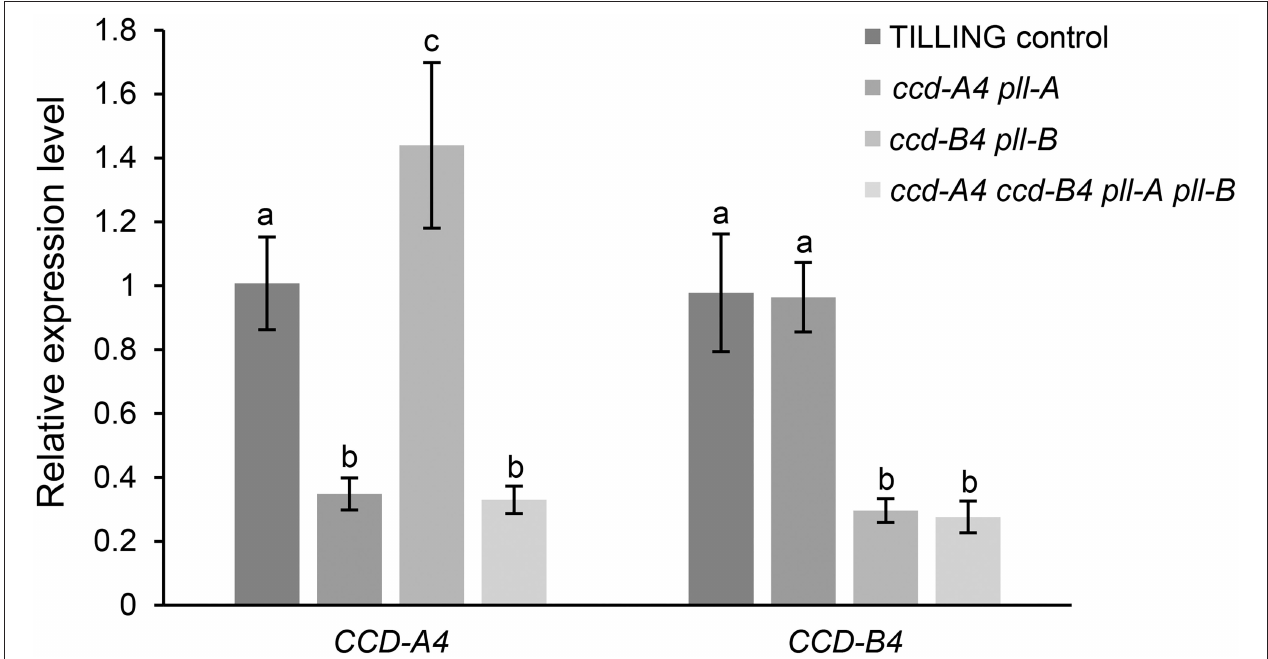
FIGURE 3 | Expression levels of CCD-A4 and CCD-B4 in leaves of TILLING control and mutant plants. Data presented are mean ± standard deviation of 4-8 biological replicates. Different letters indicate significantly different expression ( P < 0.05) for CCD-A4 or CCD-B4 in different